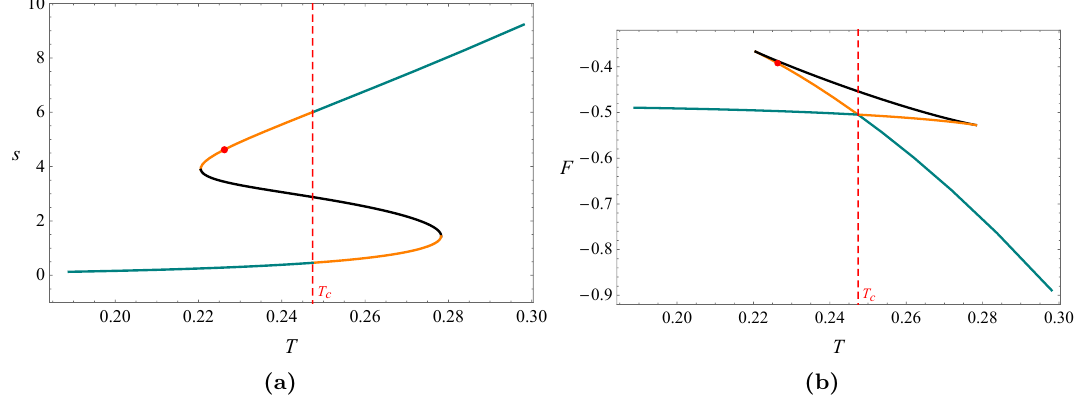
Figure 1. (a): the free energy density and (b): entropy density of the of static homogeneous solution versus the temperature. The vertical red dotted line represents the phase transition tem- perature T c = 0 . 24739 ± 0 . 00001 . The red point is the initial state of the system under